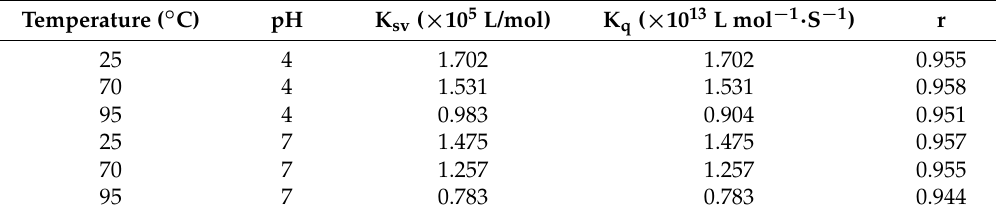
Figure 2. Stern-Volmer plots for LF fluorescence quenching by CA at pH 4 ( A ) and pH 7 ( B ). Double log plots of LF with CA at pH 4 ( C ) and pH 7 ( D ). Table 1. Stern-Volmer quenching constants of CA and LF at pH 4 and pH 7.